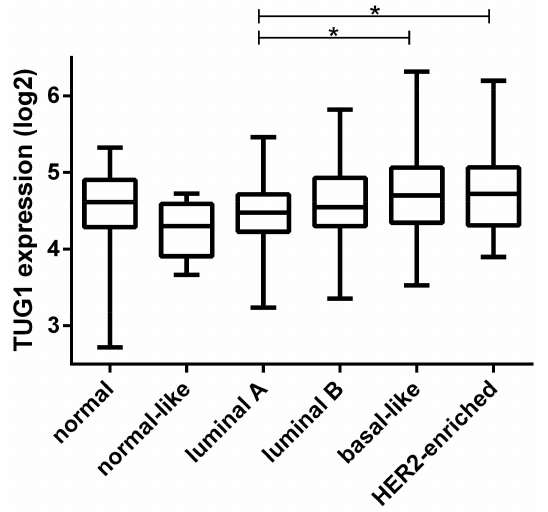
Figure 1. Expression analysis of the taurine upregulated 1 gene ( TUG1 ) transcript in Prediction Analysis on Microarrays that uses a minimal gene set (PAM50) breast cancer subgroups. TUG1 expression data were from “The Cancer Genome Atlas (TCGA)”, and the PAM50 gene signatures rely on 50 discriminatory genes to segregate tumors into luminal A ( n = 227), luminal B ( n = 122), human epidermal growth factor receptor 2 (HER2)-enriched ( n = 56), basal-like ( n = 94), and “normal-like” ( n = 7). Samples categorized as “normal” are adjacent non-tumor breast tissue ( n = 105). * p <